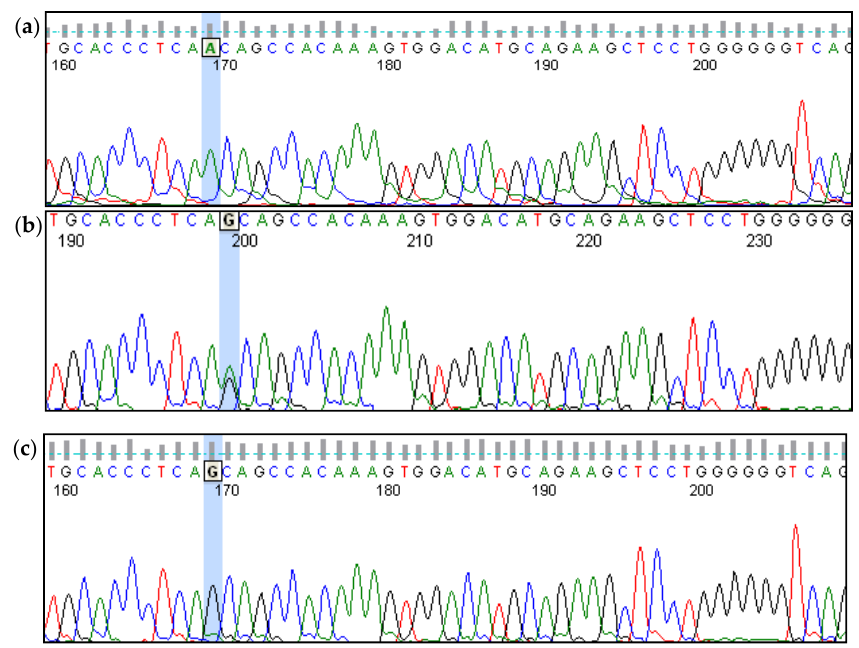
Figure 2. Chromatograms of sequencing results of the GIPC3 exon 2 fragment. ( a ) Homozygous for